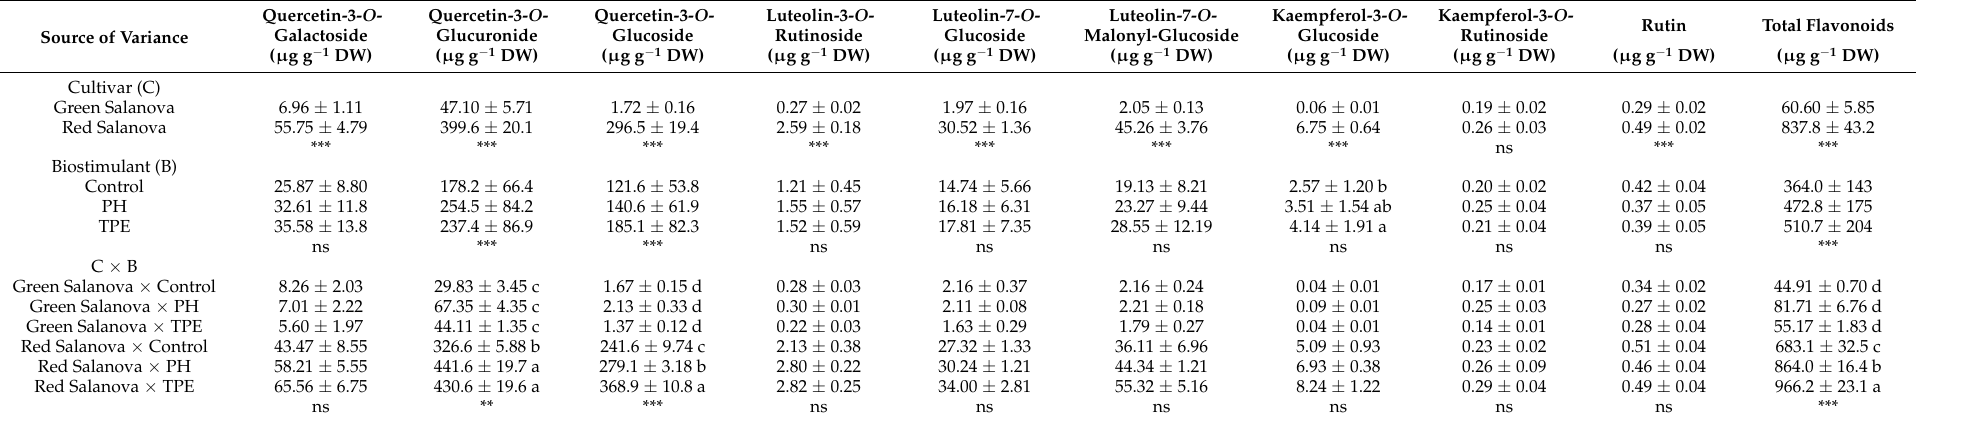
Table 6. Flavonoid contents of red and green salanova lettuce and the influence of biostimulant treatments. Source of